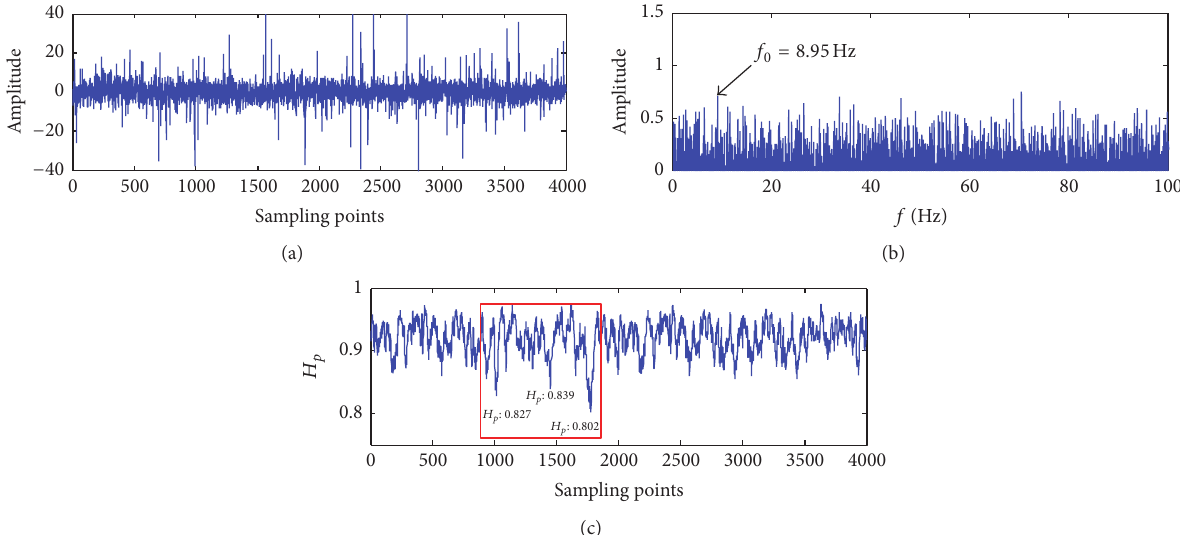
Figure 13: Mild wear of floating tile. (a) Time-domain waveform of original signals, (b) frequency spectrum of original signals, and (c) PE of original signals.